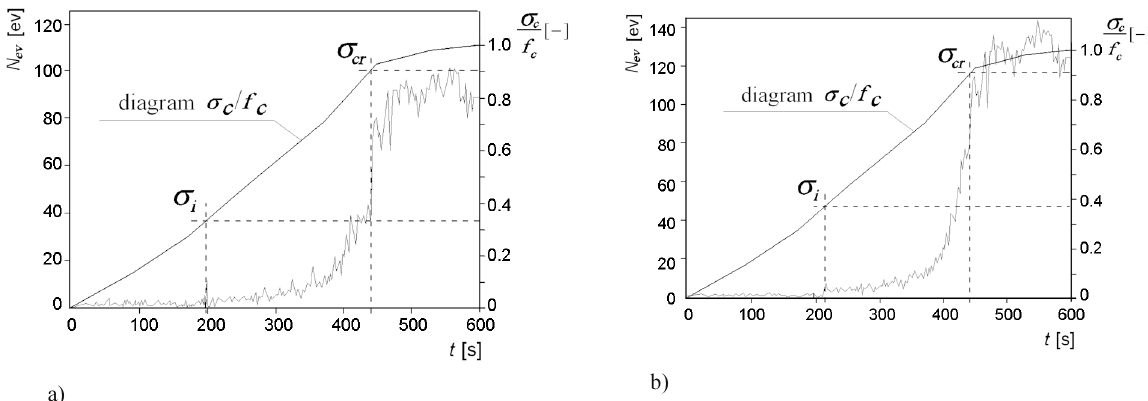
Fig. 8. AE event rate N zd , referred to relative compressive stress σ c /f c , versus failure time for self-compacting concrete: